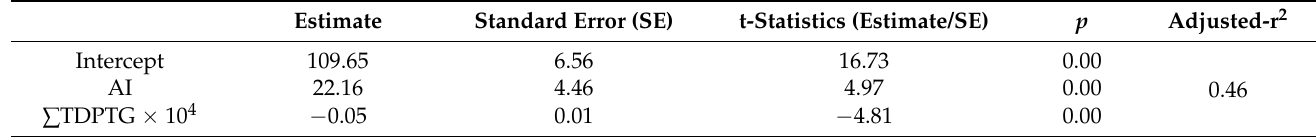
Table 3. Results of multiple linear regression